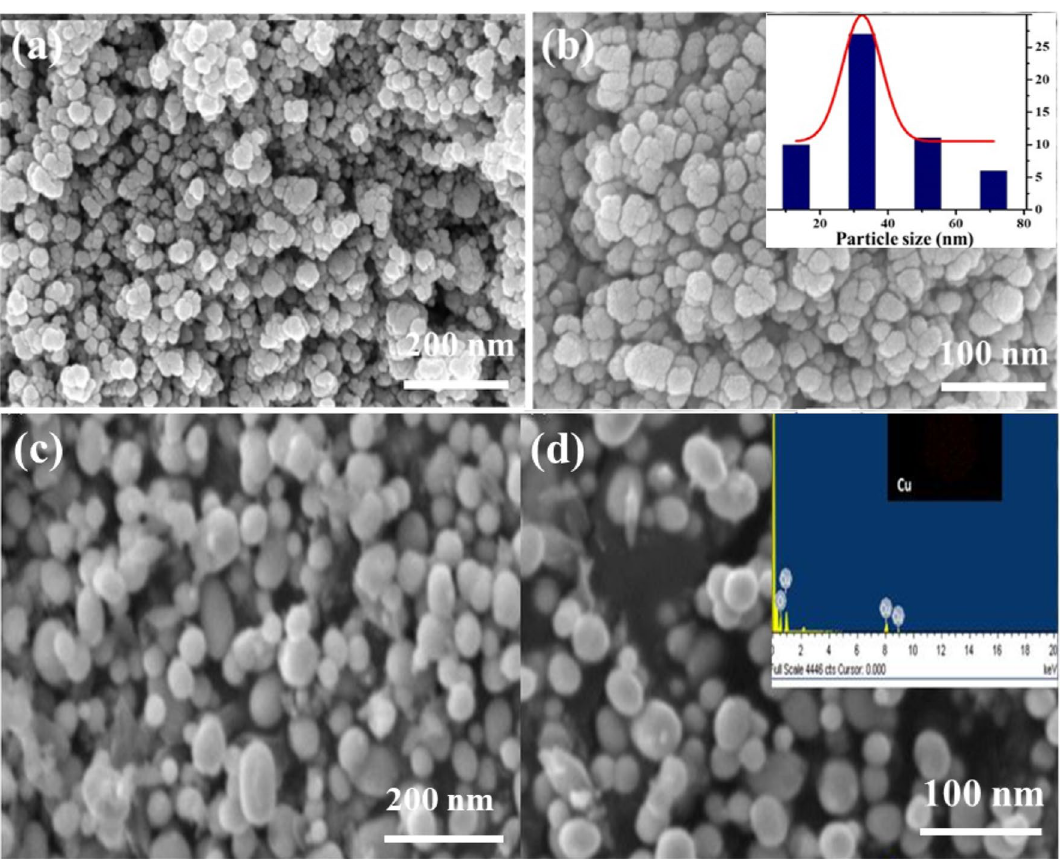
Figure 4. ( a,b ) SEM images of Cu 3 N (synthesized at 160 ml/min ammonia flow rate and 300 °C (inset: particle size distribution). ( c,d ) SEM image of Cu 2 O (inset: EDS spectra of Cu 2